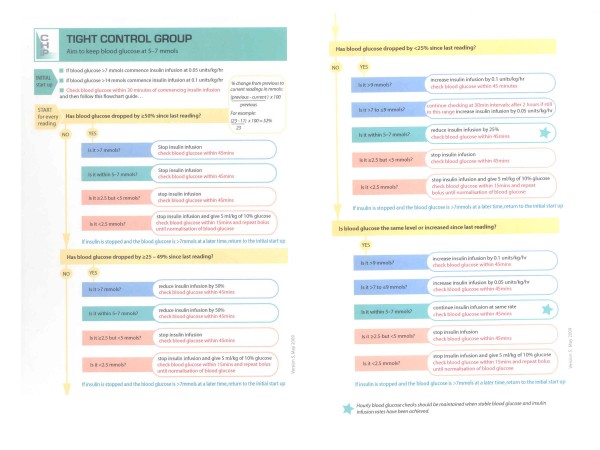
Algorithm for the titration of insulin in the tight control group.